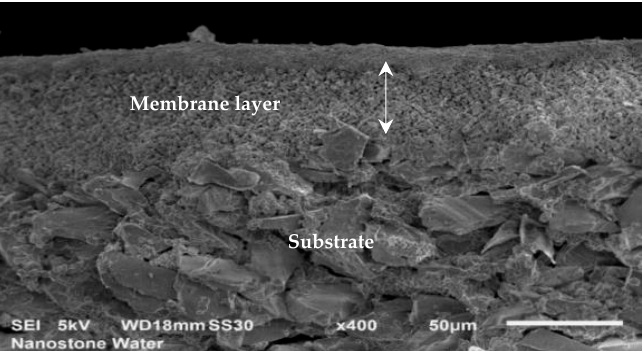
Figure 1. Cross-section profile of a ceramic mono-channel membrane.